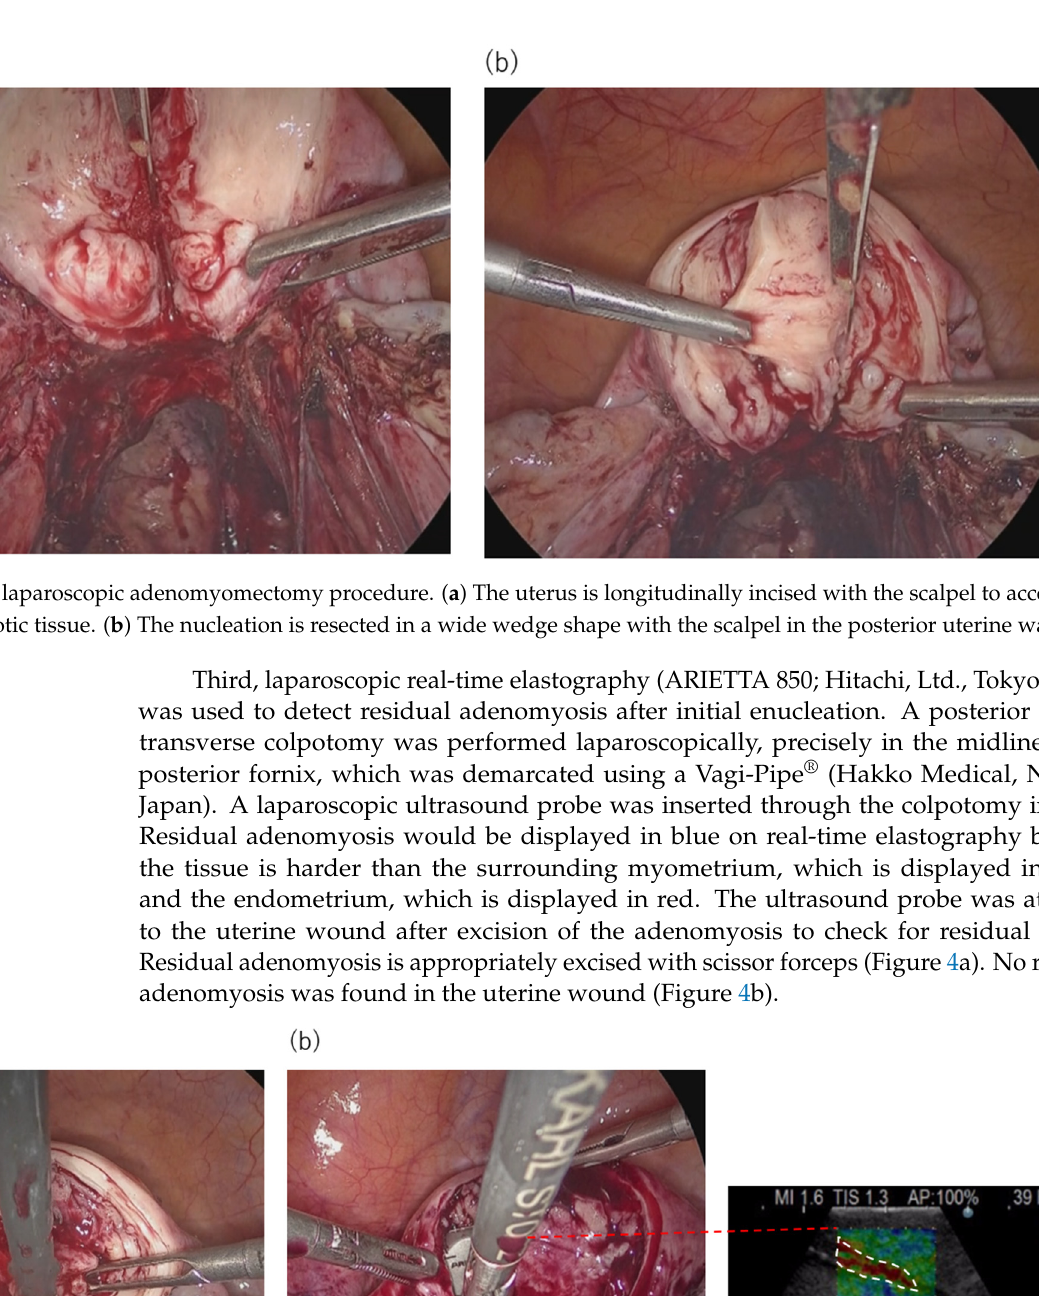
Figure 2. ( a ) The rectum adhered to the posterior wall of the uterus, and the pouch of Douglas was completely closed. ( b ) The ureter was entrapped in the DE around the left sacrouterine ligament. ( c ) When the ureter was detached from the DE, the ureter was completely opened.